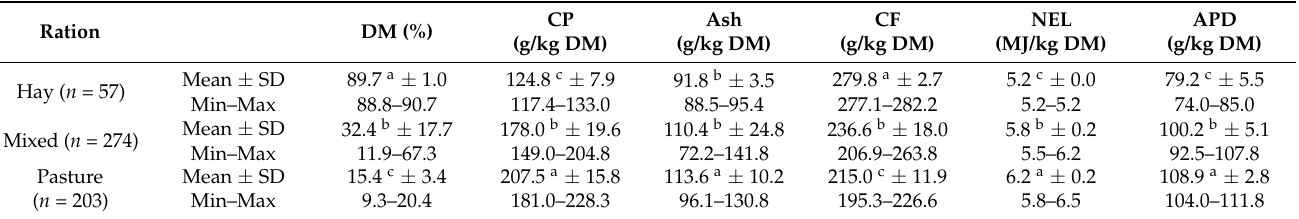
Table 4. Chemical feed composition and nutritive values aggregated to three ration types (hay, mixed and pasture) across visits and